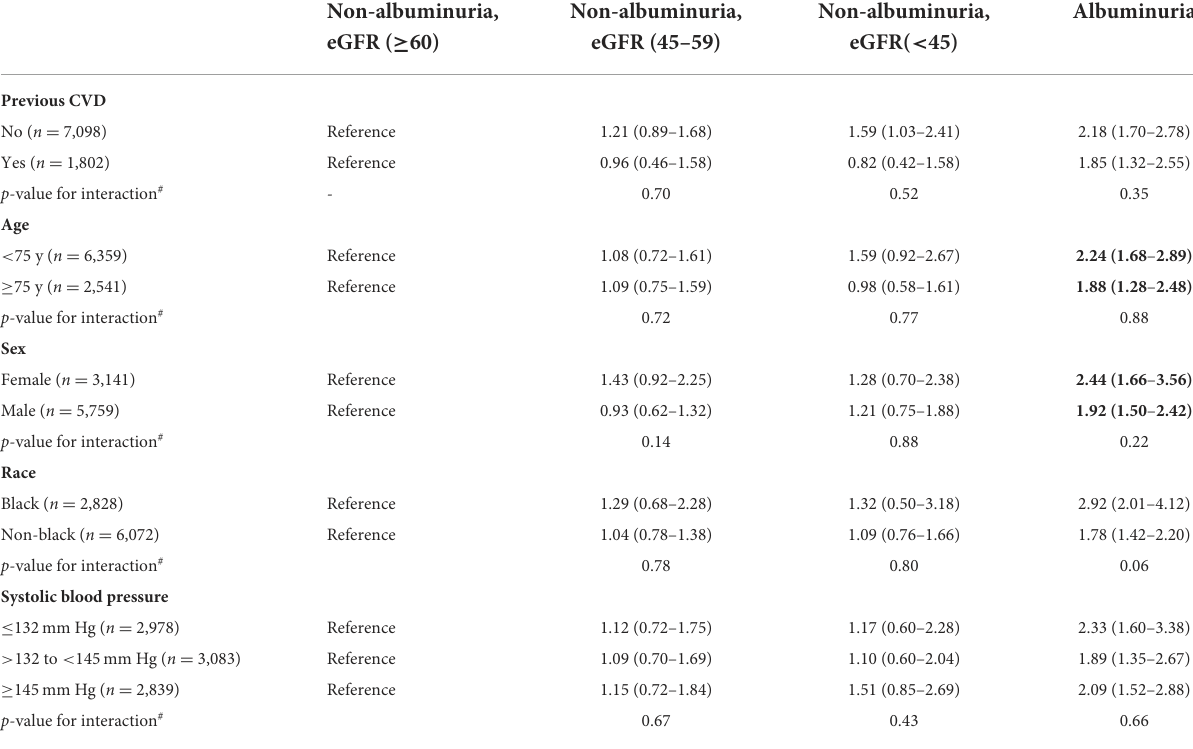
TABLE 3 Risk of primary outcomes by baseline CKD and albuminuria status according to